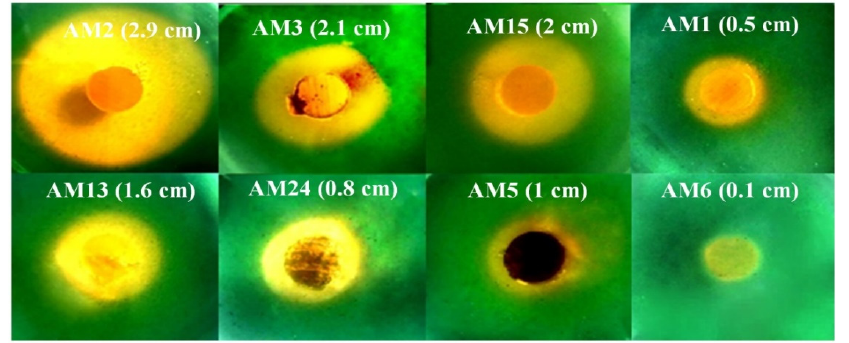
Figure 3. Halo of discoloration of CAS-agar around agar plugs of the eight most efficient TCP/RP solubilizing actinomycete isolates grown for 5 days in solid SMM containing 0.5 g/L TCP and de- posited on the surface of a CAS–blue agar plate. Diameters of the halos are expressed in cm.